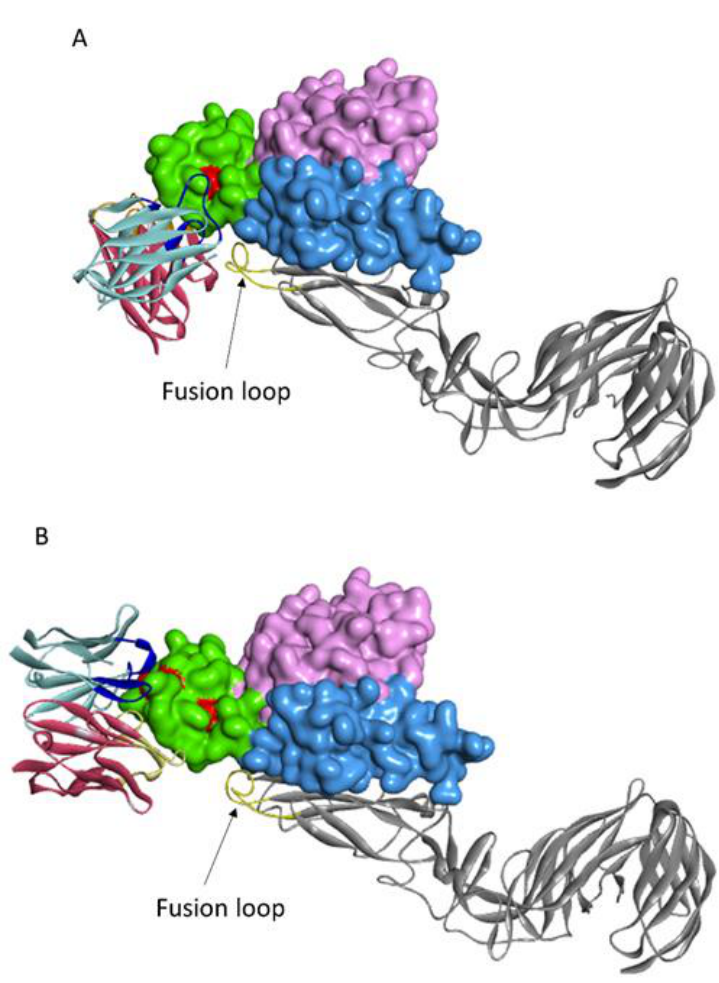
Figure 7. Modeling structure of NAbs and RVFV Gn–Gc assembly. ( A ) Overall structure of 1332F11 and RVFV Gn–Gc assembly. Fusion loop in Gc is shown as gold, and the rest of Gc is indicated as silver gray. NAbs and Gn are described as in Figure 6. ( B ) Overall structure of 1331E4 and RVFV Gn–Gc assembly, as presented in ( A ).